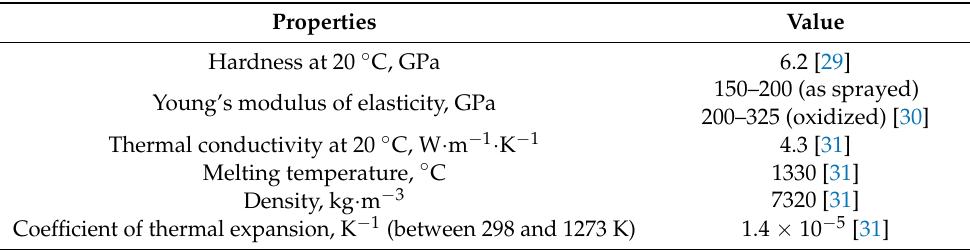
Table 2. Main properties of